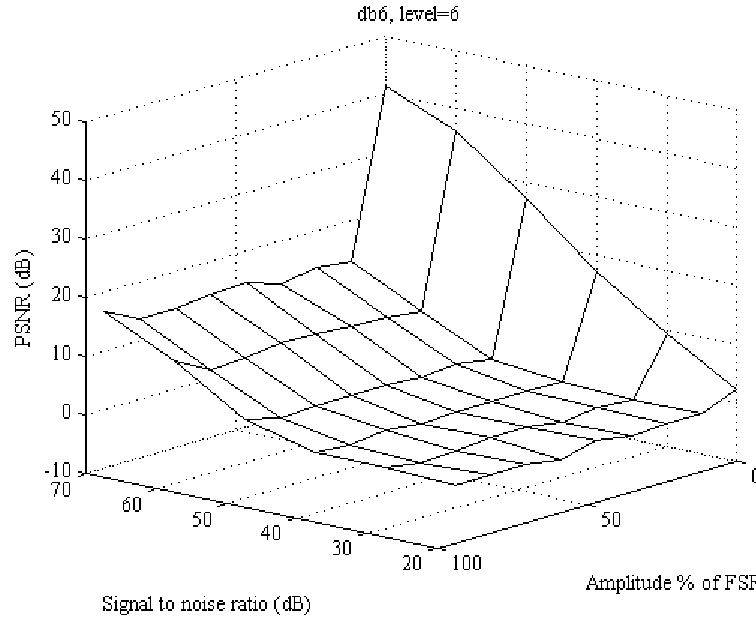
Figure 15. Difference between simulation and measurement.